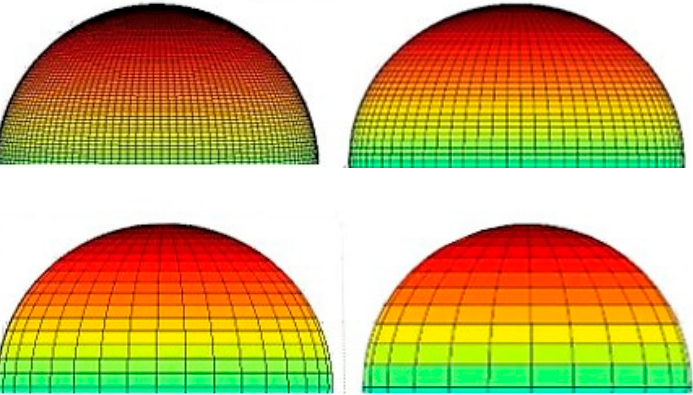
Figure 2. Equiangular subdivision of the skydome: 3, 5, 10, and 15 degrees, corresponding to sets of 3241, 1081, 289, and 121 light sources. 3241, 1081, 289, and 121 light